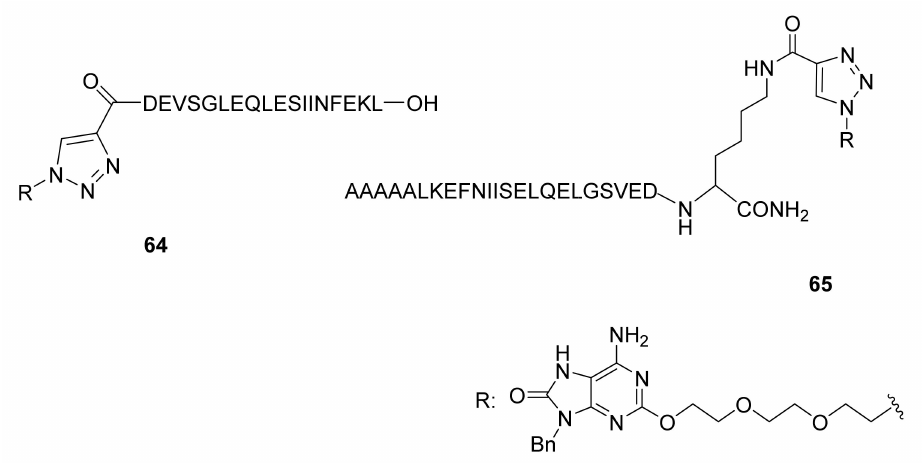
Figure 22. Triazole peptide derivatives with conjugated